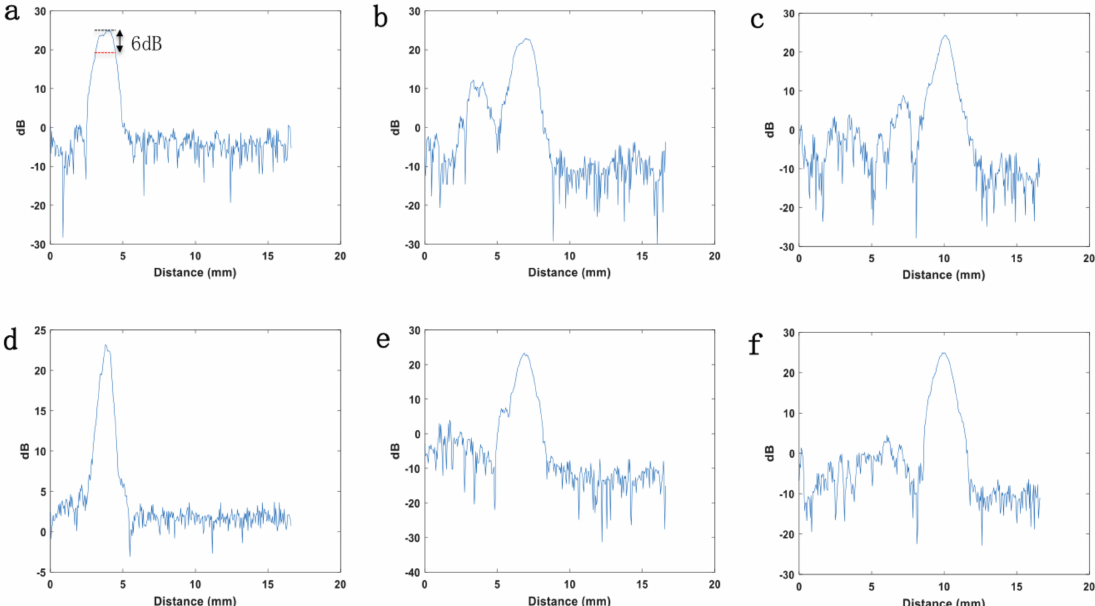
Figure 7. Signal magnitude (dB) versus scanning distance for lateral resolution measurement. The resolution was measured when the depth between wire and single element were 5.6 mm ( a ), 6.8 mm ( b ) and 8 mm ( c ). The resolution was then measured when the depth between wire and annular array were 5.6 mm ( d ), 6.8 mm ( e ) and 8 mm ( f